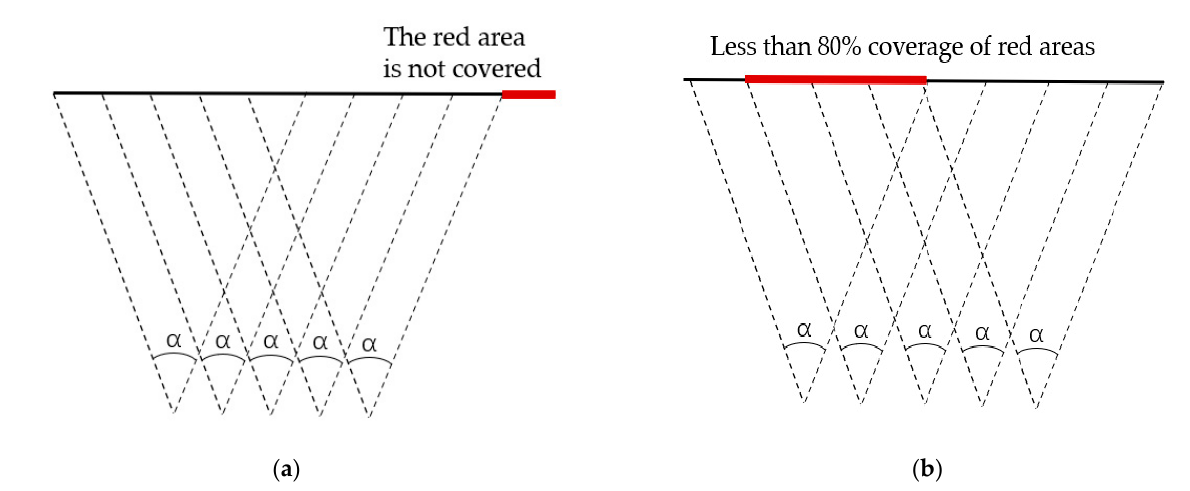
Figure 16. Comparison of different results when lacking one of the conditions: ( a ) 80% overlap at five cameras, no full coverage, and ( b ) full coverage at five cameras, overlap < 80%.